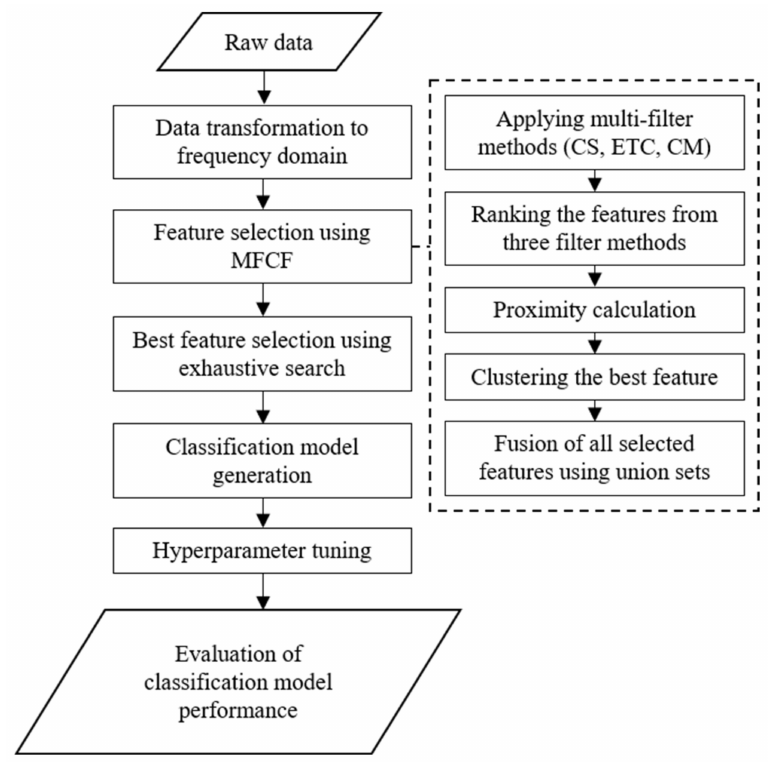
Figure 1. Flow chart of the proposed